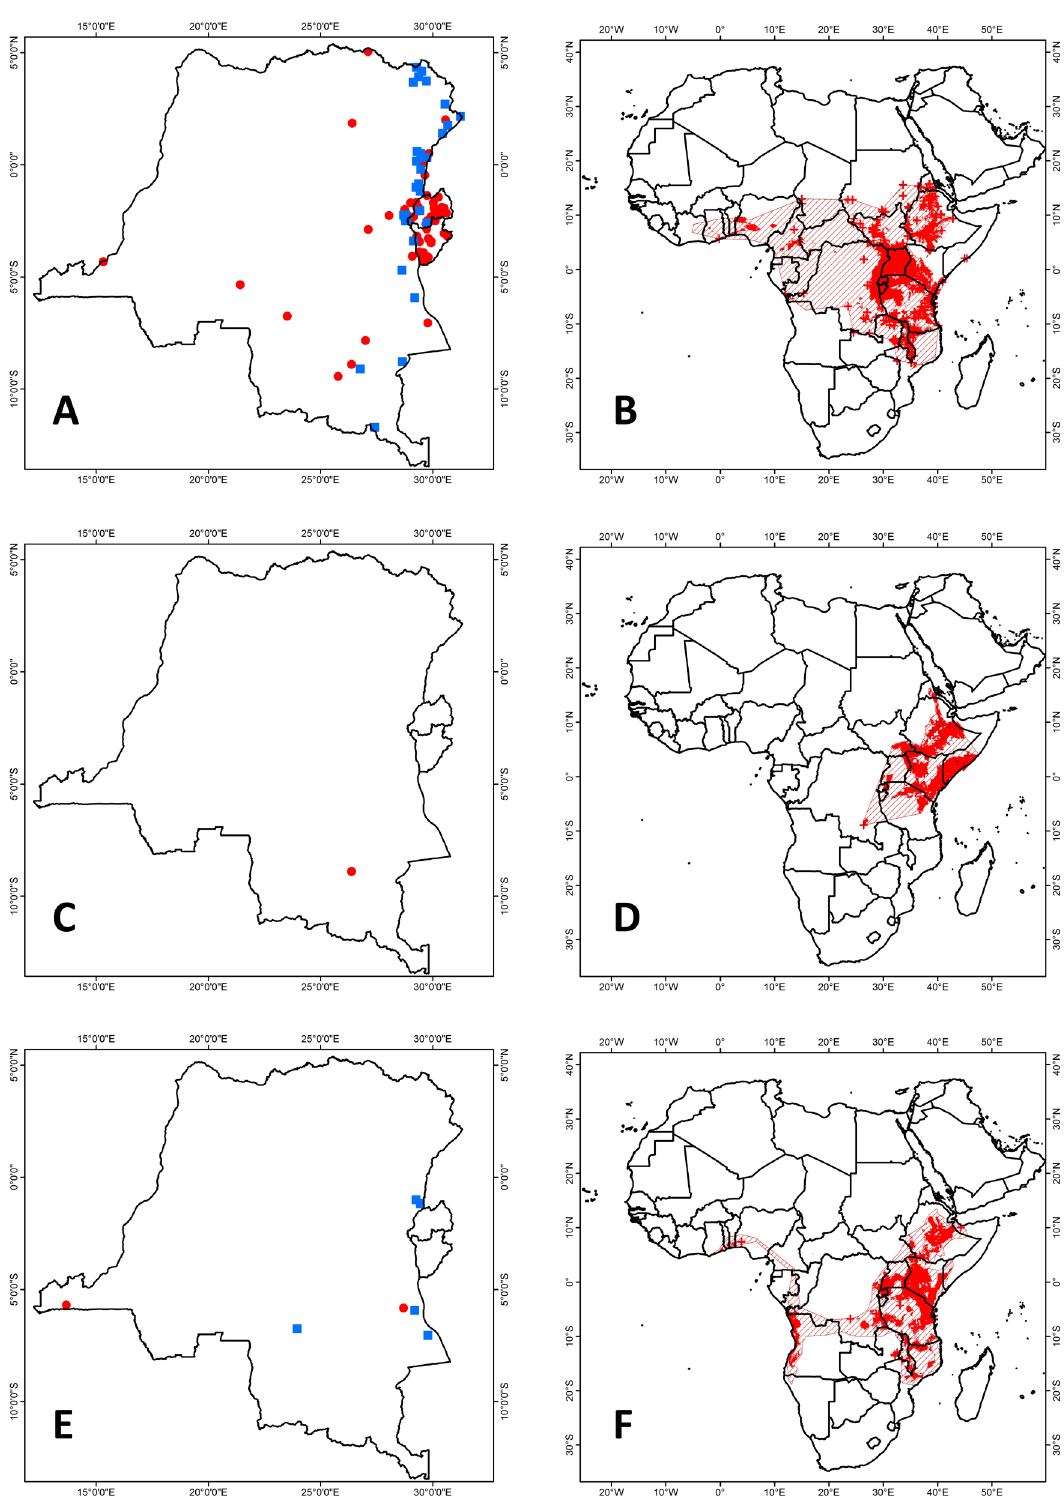
Fig. 4. Distribution maps. A–B . Epomophorus labiatus (Temminck, 1837). C–D . Epomophorus minimus Claessen & De Vree, 1991. E–F . Epomophorus minor Dobson, 1880. A, C, E. Distribution in the